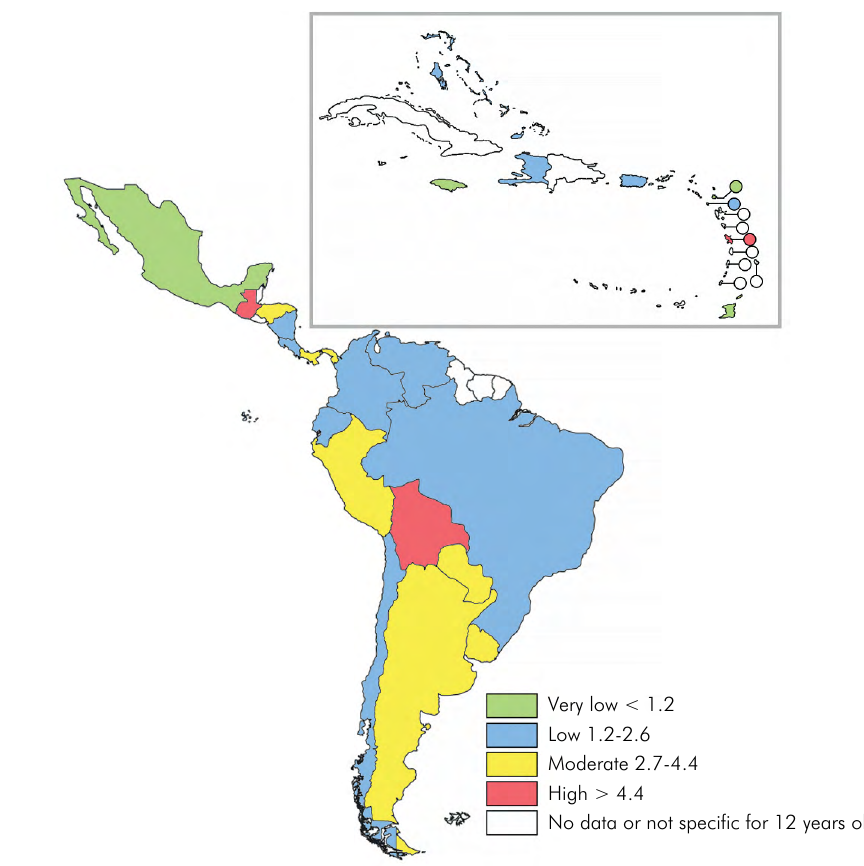
Figure 2. Prevalence of dental caries [DMFT: Decayed, Missing and Filled Teeth index] among children aged 12 years in Latin American and Caribbean